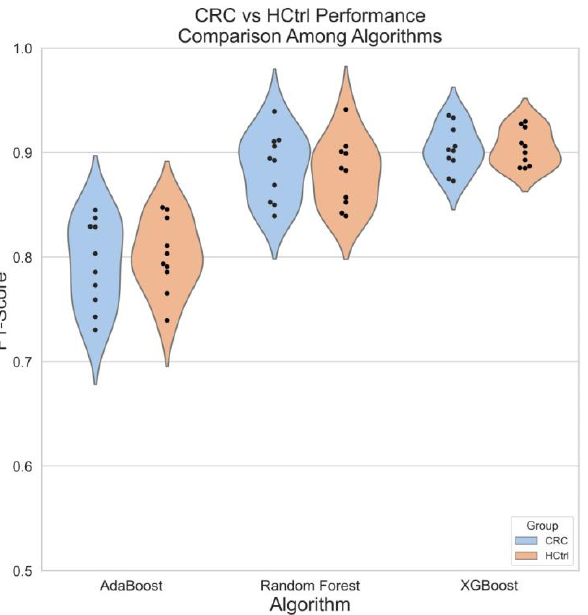
Figure 7. Violin plots from the F1 scores of the classification models from CRC patients and healthy control subjects. Three tree-based classifier algorithms, AdaBoost, random forest, and XGBoost, were selected for classification. Each model was run 10 times. Orange: healthy control (HCtrl); blue: colorectal cancer (CRC). F1 Score = 2 ∗ ( Precision ∗ Recall )/( Precision + Recall ) .